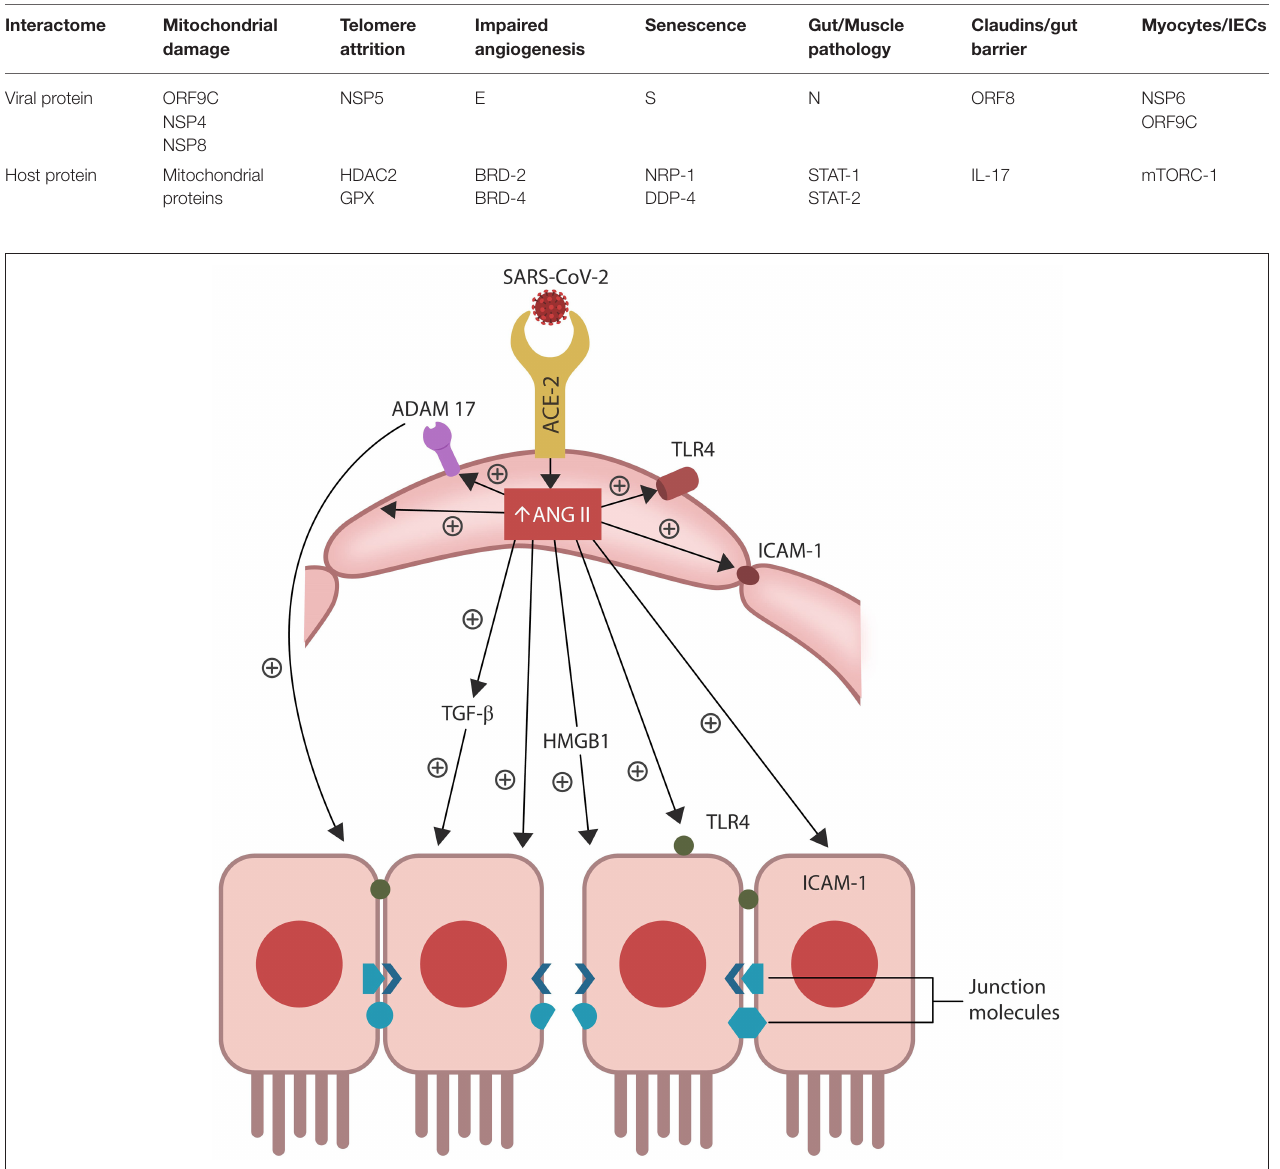
FIGURE 2 | ANG II accumulation in ECs alters several senescence-associated pathways, including ADAM17-downregulation of ACE-2 in ECs and IECs. ANG II-upregulated pathways include TGF- β , HMGB1, TLR4, ICAM-1, and SASP (not shown). Together these molecules induce cellular senescence, increasing intestinal and BBB permeability likely contributing to